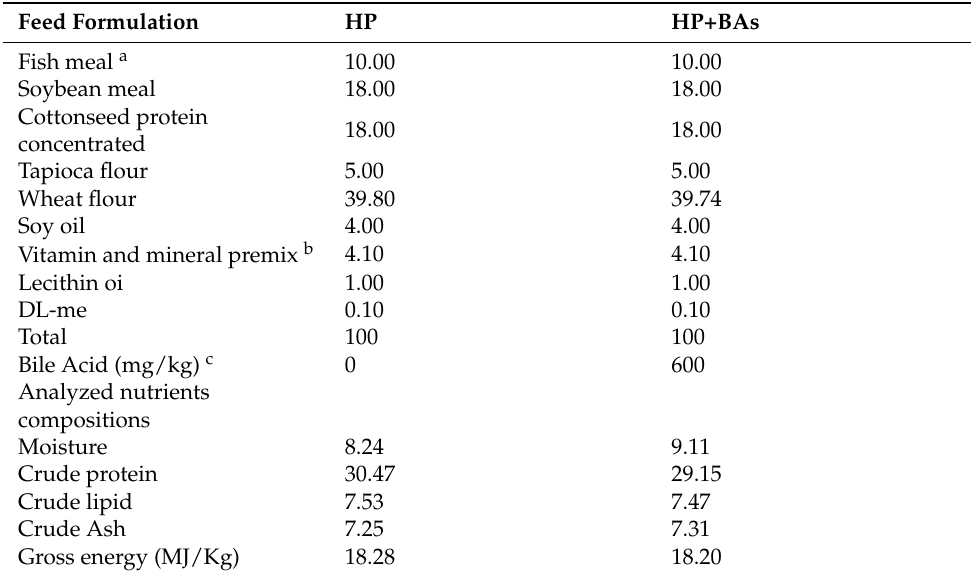
Table 2. Experimental diets’ formula and composition of HP and HP+BAs groups (air-dry basis, %) (The content of this table has been published